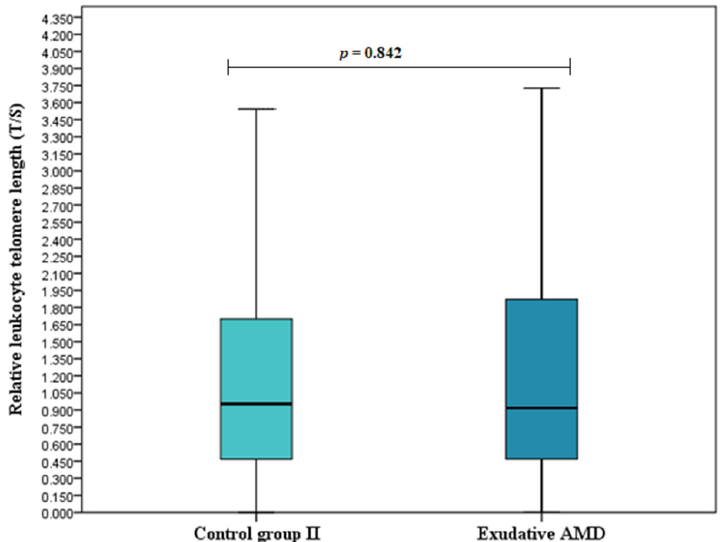
Figure 2. Relative leukocyte telomere length in exudative AMD patients and the control group II. Relative leukocyte telomere length (T/S) in exudative AMD patients versus healthy controls are presented as box-and-whisker plots with the median and IQR. Mann–Whitney U test assessed T/S differences between patients with exudative AMD and control groups; p = 0.842.